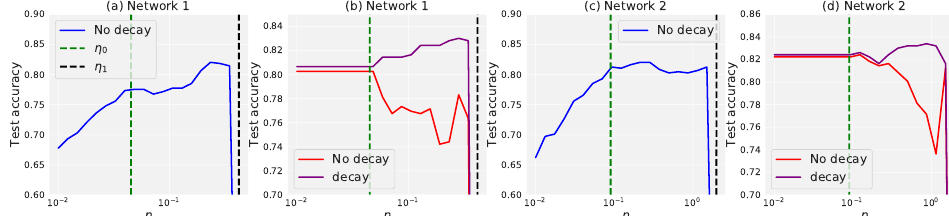
Figure 4. Test performance on the CIFAR-10 dataset with respect to different learning rate phases. The data size is of n train = 2048 and n test = 512. ( a , b ) A two-layer linear network without bias of σ 2 w = 0.5 and m = 500. ( c , d ) A three-layer linear network with the bias of σ 2 w = 0.5, σ 2 m = 500. ( a , c ) The test accuracy is measured at the time step t = 500 and t = 300, respectively. The optimal performance is obtained when the learning rate is in the catapult phase. ( b , d ) The test accuracy is measured at the physical time step (red curve), after which it continues to evolve for a period of time at a small learning rate (purple): t phy = 50/ η and extra time t = 500 at η = 0.01 for the decaying case. Although the results in the catapult phase do not perform as well as the lazy phase when there is no decay, the best performance can be found in the catapult phase when adopting learning rate